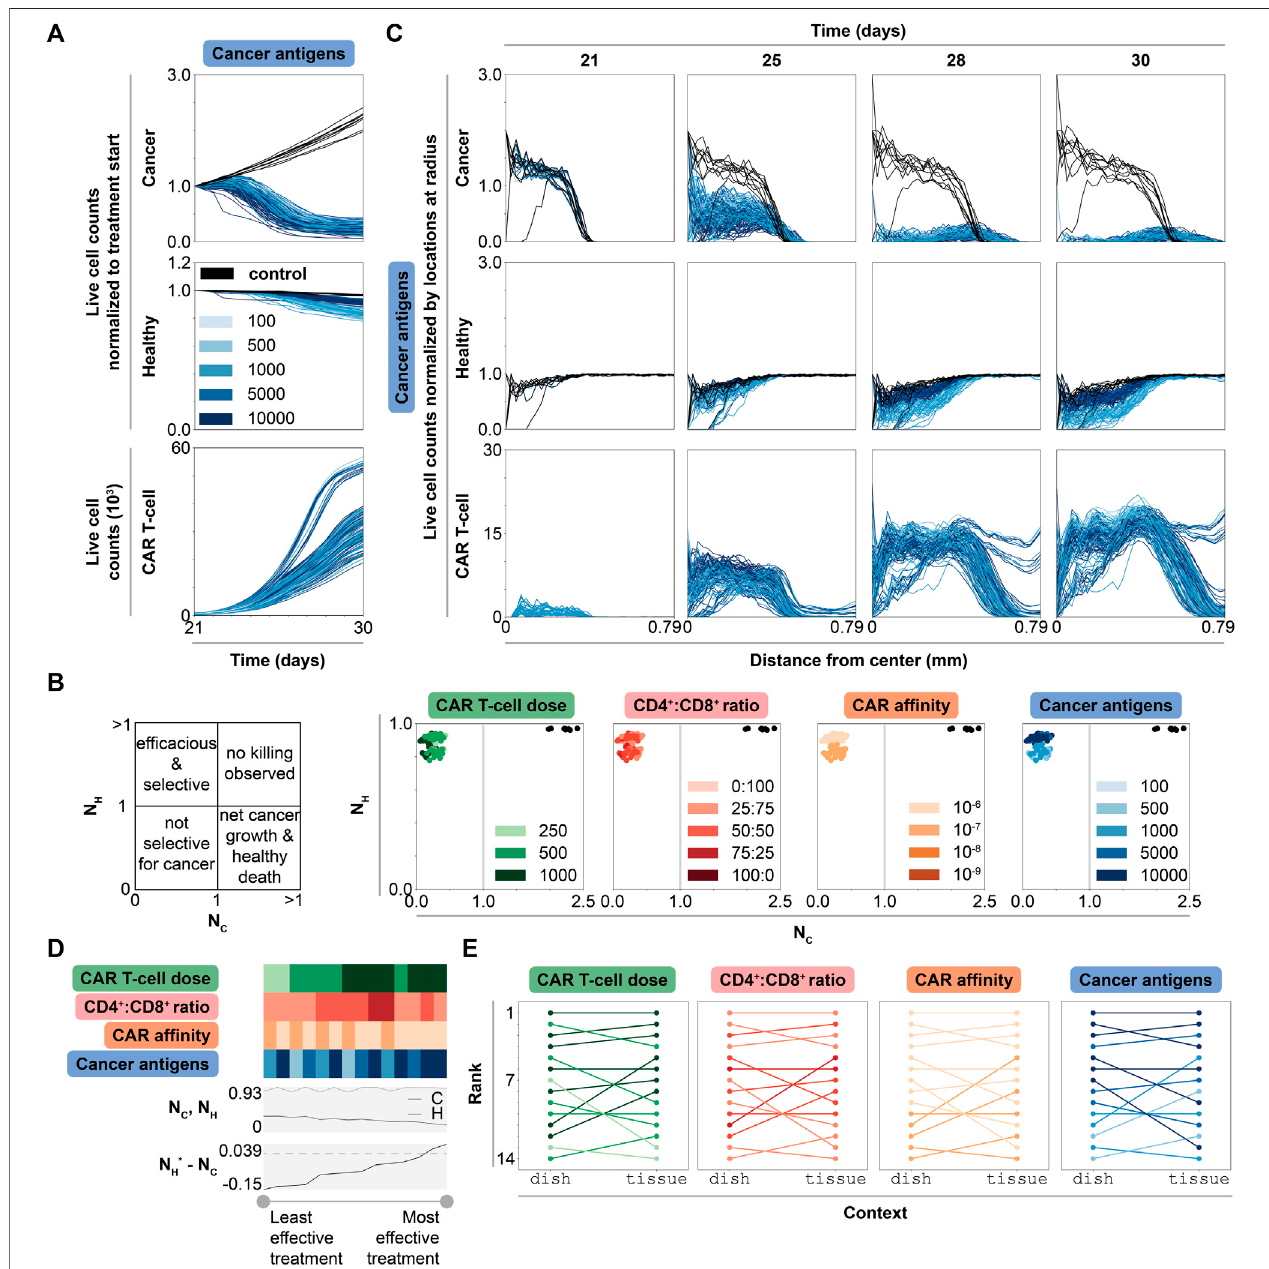
FIGURE 5 | Dynamic, spatial, and ranked outcomes for selected promising treatment combinations in tissue . (A) Live cell counts over time of untreated (black) and treated conditions (graded hues) normalized to cell count at start of treatment (t = 21 d), for all simulations, colored by cancer antigens (other features may be changing as well). Cancer antigens reported in antigens/cell. The same data colored by other features are shown in Supplementary Figure S12 (B) Scatter plots of normalized live cancer cell count ( N C , x -axis) vs normalized live healthy cell count ( N H , y -axis), each normalized to initial value at start of treatment (t = 21 d), for untreated(black)andtreatedconditions(gradedhues)forallsimulations,coloredbyonefeatureatatime.Eachfeatureisreportedinthefollowingunits:CART-celldose =numberofCART-cells,CD4 + :CD8 + ratio=unitless,CARaf fi nity=M,cancerantigens=antigens/cell. (C) Normalizedlivecellcountsovertime(t=21,25,28,and30d shown) for untreated (black) and treated conditions (graded hues), normalized to locations per radius, for all simulations, colored by cancer antigens. The columns indicate the timepoint in the simulation (day), while the rows indicate cell type plotted, and the x -axis for each plot shows the distance from the center. Legend is consistentwithpanel B. (D) Heatmap showingvaluesforeach feature withlineplotsshowing normalized livecancerandhealthycellcountsanddifference innormalized livehealthyand cancercellcounts ( N p H − N C ,where healthy cellvalueismultipliedbytheratioofcancertohealthy cellsat thestartoftreatment toensure equal weighting since initial cell population sizes are not equal; dashed line indicates value of 0) at fi nal time point averaged across replicates. The heatmap is sorted from lowest (left) to highest (right) difference. Feature legends are consistent with panels A and C. (E) Ladder plots of condition rankings in both dish and tissue , where condition outcome (averaged across replicates) is colored by each corresponding